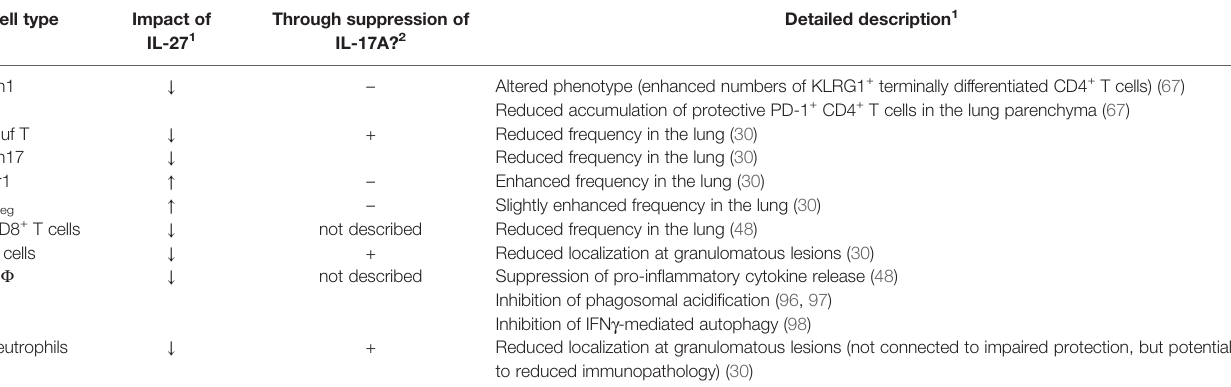
TABLE 1 | Direct and indirect effects of IL-27-mediated signalling on different immune cell populations in the context of TB. Cell